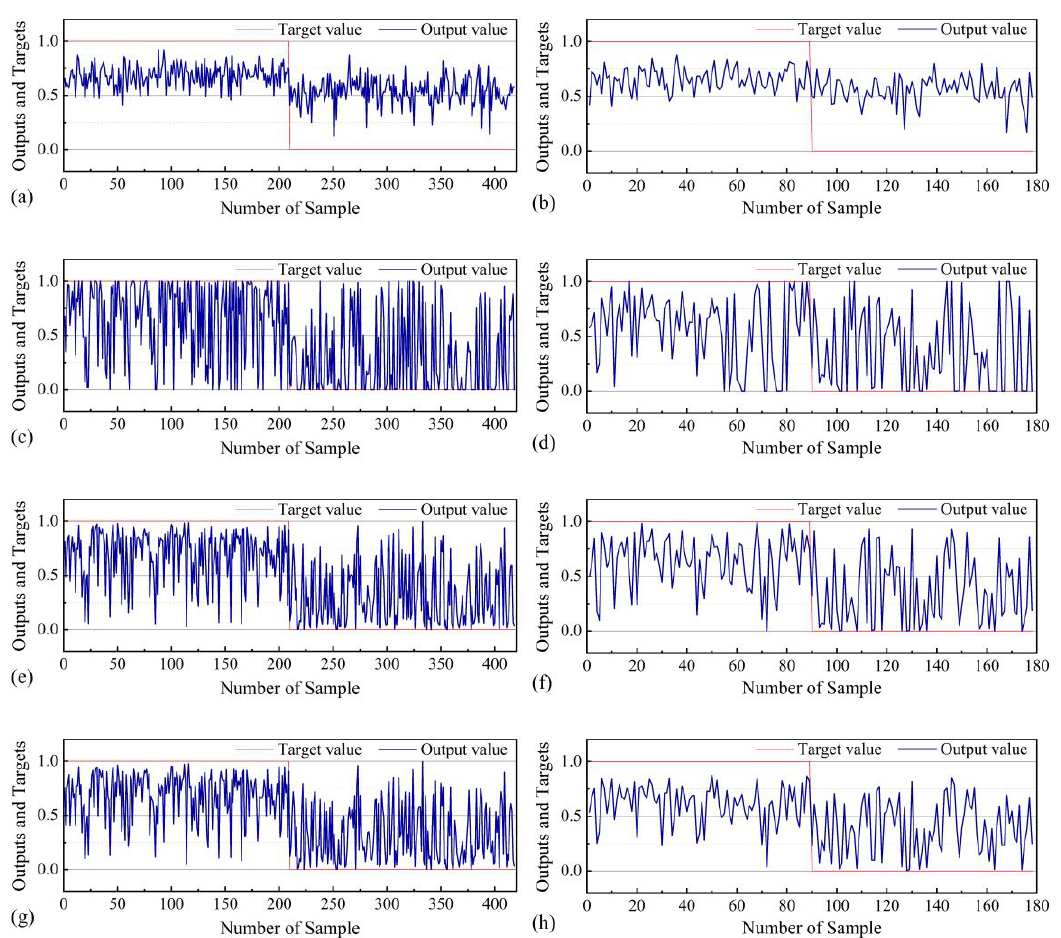
Figure 10. Target and output values for the evidential belief function (EBF) model of ( a ) training and ( b ) validation dataset samples; FT model of ( c ) training and ( d ) validation dataset samples; logistic regression (LR) model of ( e ) training and ( f ) validation dataset samples; LMT model of ( g ) training and ( h ) validation dataset samples.